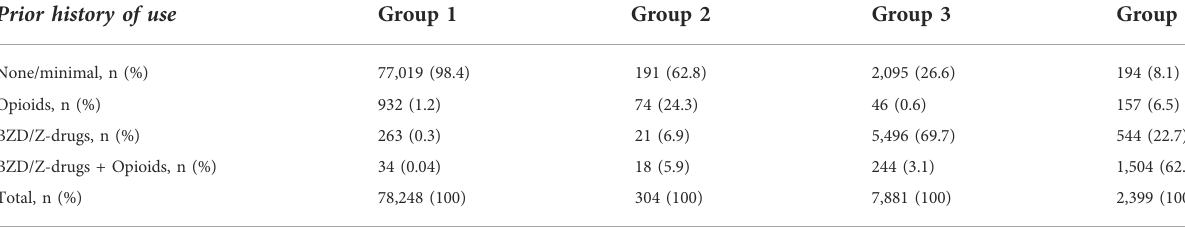
TABLE 6 Prior history of benzodiazepine/Z-drug and opioid use in the four study groups in